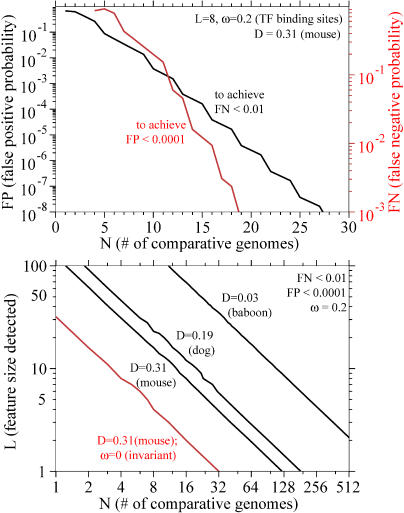
Increase in Stringency and Resolution with Increasing Genome NumberTop: black line shows improvement in specificity (FP) for transcription factor (TF) binding site–like features (L = 8, ω = 0.2) as comparative genome number increases, for FN = 0.01 (99% of sites detected), and genomes of D = 0.31 (mouse/human-like distance). Red line shows improvement in sensitivity (FN) for the same parameters and a FP threshold of 0.0001. Shown as a log-linear plot to show the expected rough log(FP or FN) proportional to −N scaling.Bottom: resolution (size of detectable feature, L) as a function of comparative genome number, plotted on log-log axes to show the fit to the expected L ∝ 1/N scaling. All four lines assume goals of FN < 0.01 and FP < 0.0001. Black lines are for identifying conserved features evolving 5-fold slower than neutral (ω = 0.2), using baboon-like (D = 0.03), dog-like (D = 0.19), or mouse-like (D = 0.31) genomes. Red line is for identifying invariant features with mouse-like genomes.